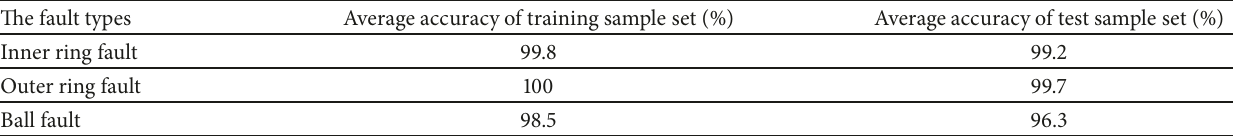
Table 1: Training accuracy and test accuracy of each type of fault.